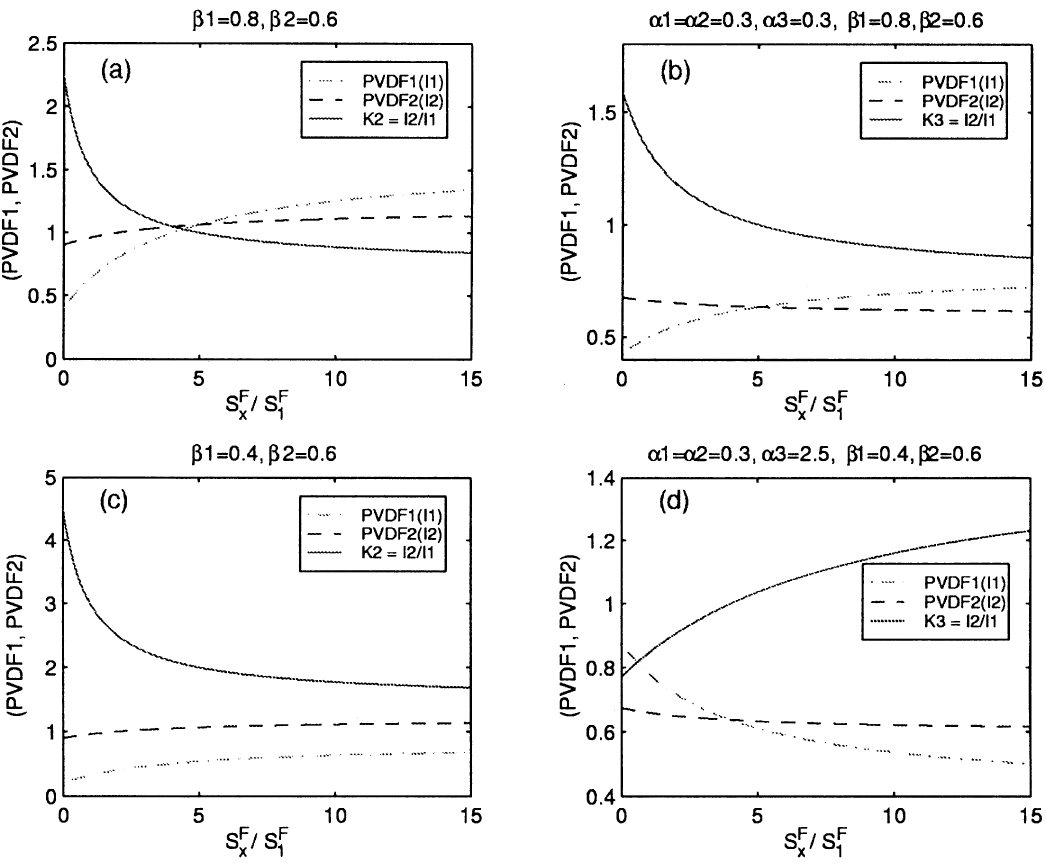
Fig. 9. Simulation of sensor output for Case 2 and Case 3. (a) ( β 1 , β 2 ) = (0 . 8 , 0 . 6) , (b) ( β 1 , β 2 ) = (0 . 4 , 0 . 6) , (c) α 1 = α 2 = α 3 = 0 . 3 and ( β 1 , β 2 ) = (0 . 8 , 0 . 6) , (d) α 1 = α 2 = 0 . 3 , α 3 = 2 . 5 and ( β 1 , β 2 ) = (0 . 4 , 0 . 6)